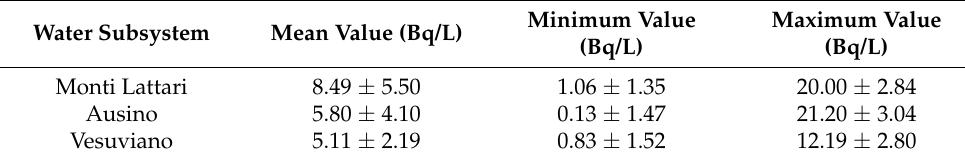
Figure 4. Variability of tritium concentration of the water subsystems. The graph report median, 25th, and 75th percentile. The graph reports a horizontal line in correspondence to the value of the MDA equal to 3 Bq/L. Table 8. Values of tritium concentration for each water subsystem analyzed.